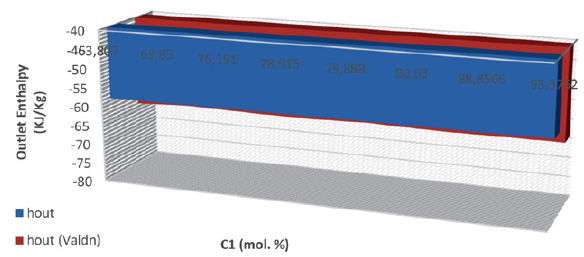
Fig. 1. Effect of methane concentration variation on outlet enthalpy (kJ/kg), Constant outlet conditions